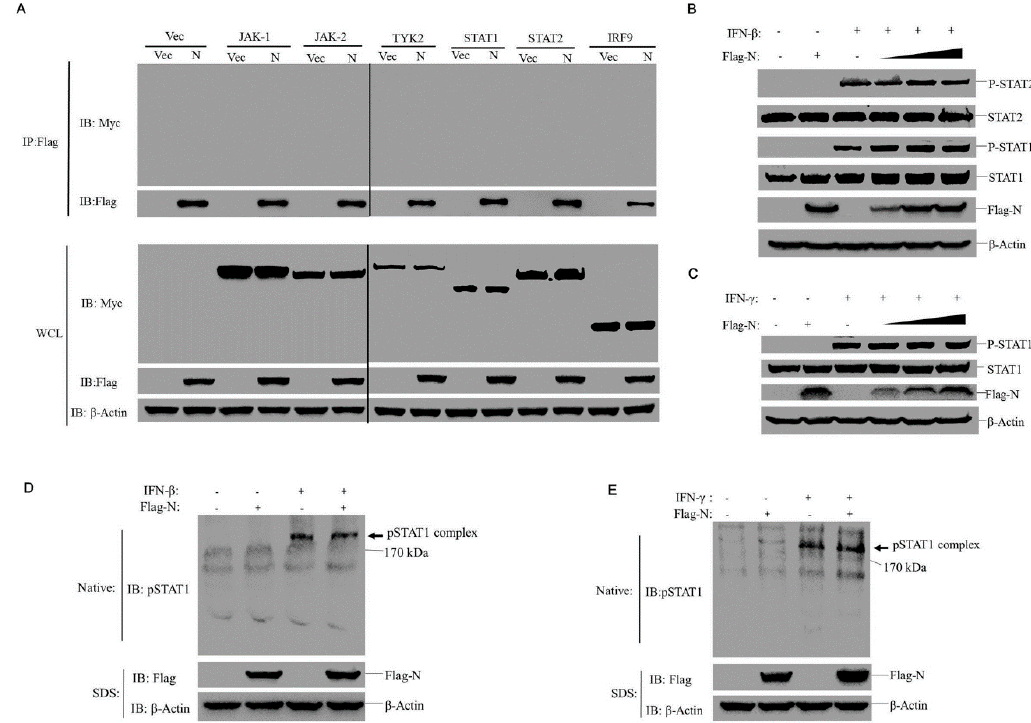
Figure 4. N protein did not interact with molecules of the JAK-STAT pathway or inhibit STAT’s Figure4.